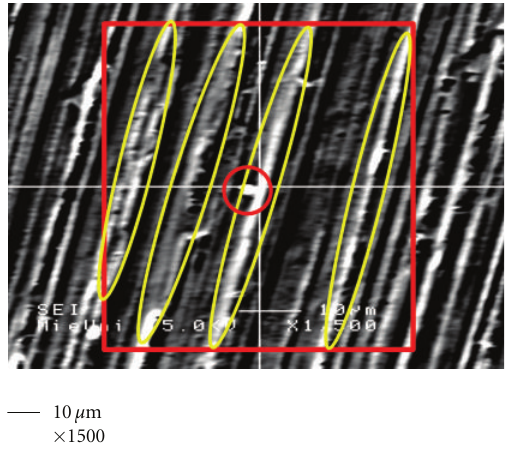
Figure 6: SEM image of Ag-doped TiO 2 film prepared under the condition of R = 1